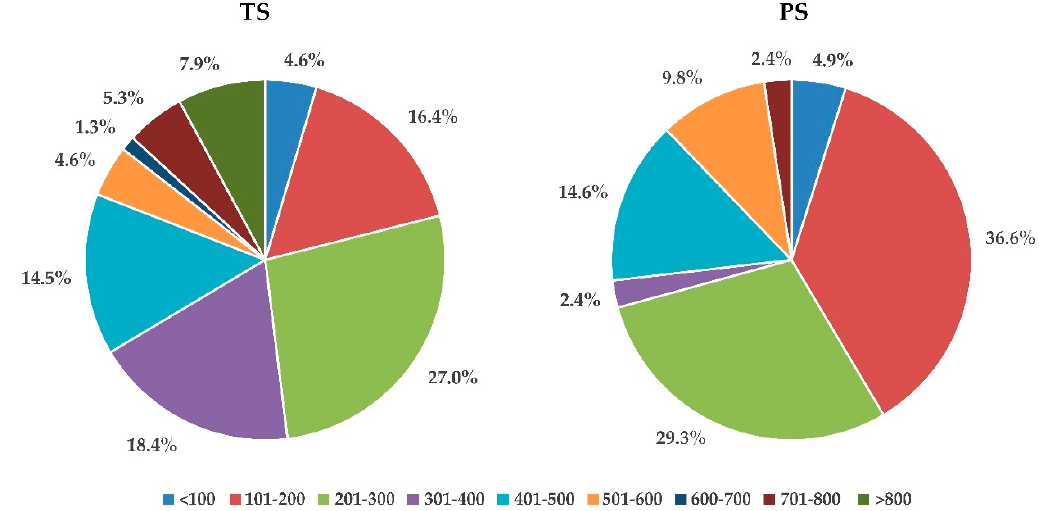
Figure 4. Distribution of precursors according to the peptide chain length (aa) in di ff erent samples.